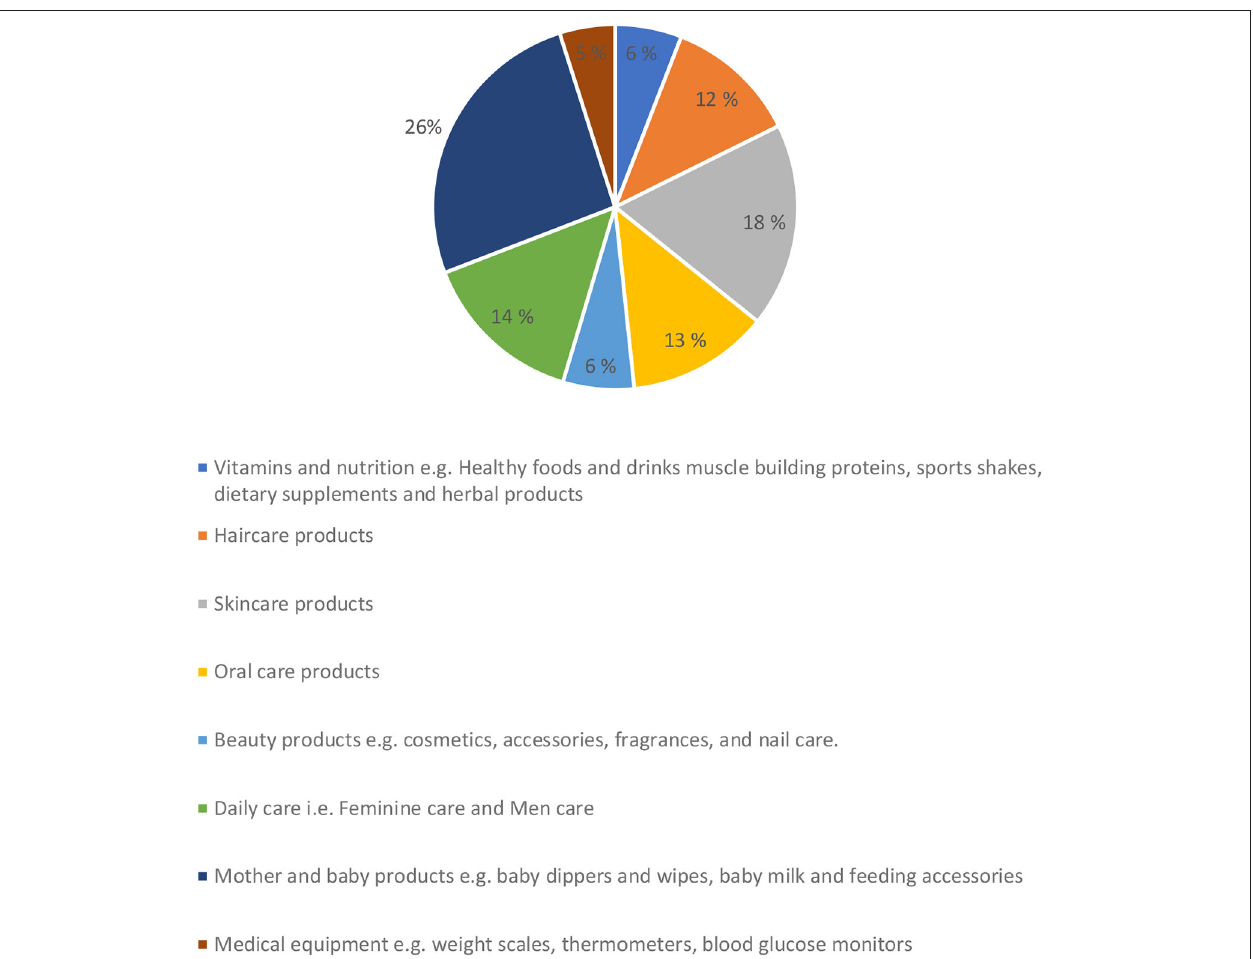
FIGURE 1 | Bestselling non-pharmaceutical products sold in community